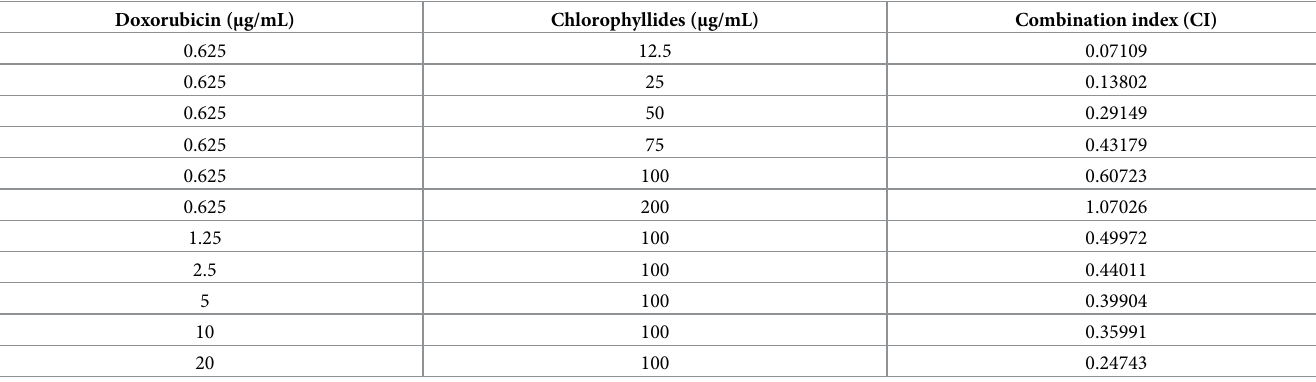
Table 2. Combination effects of doxorubicin and chlorophyllides in the MDA-MB-231 cell line. Doxorubicin ( μ g/mL) Chlorophyllides ( μ